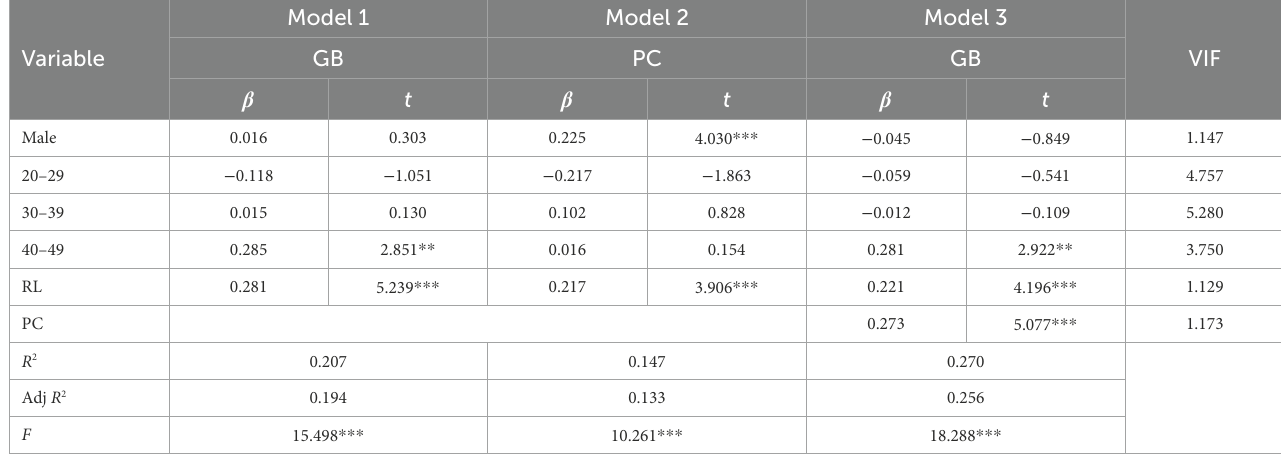
TABLE 2 Mediating effect of psychological capital on the relationship between responsible leadership on teacher green behavior.